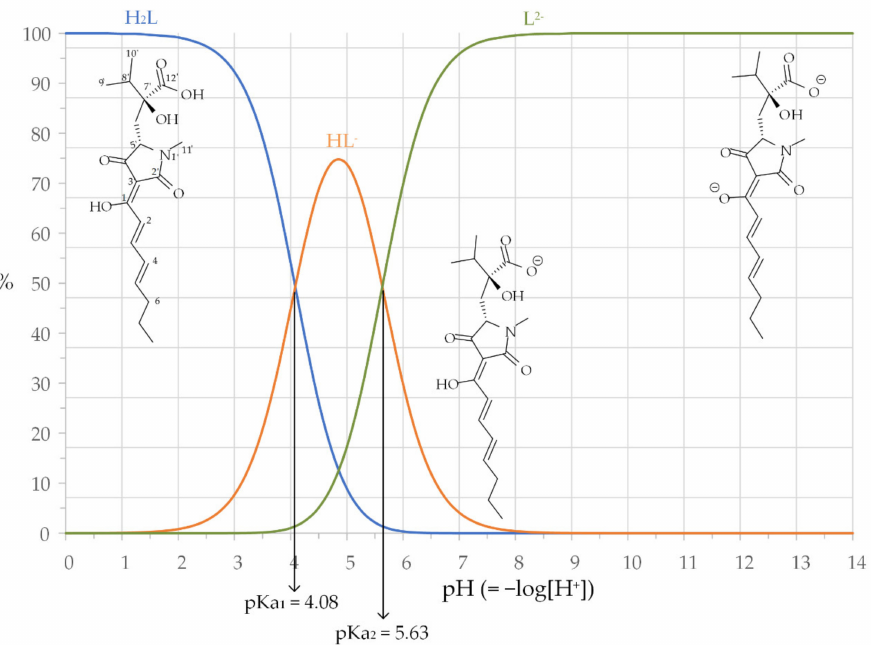
Figure 1. Distribution diagram of harzianic acid (H 2 L). Reported dissociation constants of harzianic acid were separately determined at 25 ◦ C in the mixed solvent CH 3 OH/0.1 M NaClO 4 (50:50 w/w ) [16]. Inserts: structures of harzianic acid (H 2 L) and its acid-dissociated products (HL − and L 2 −